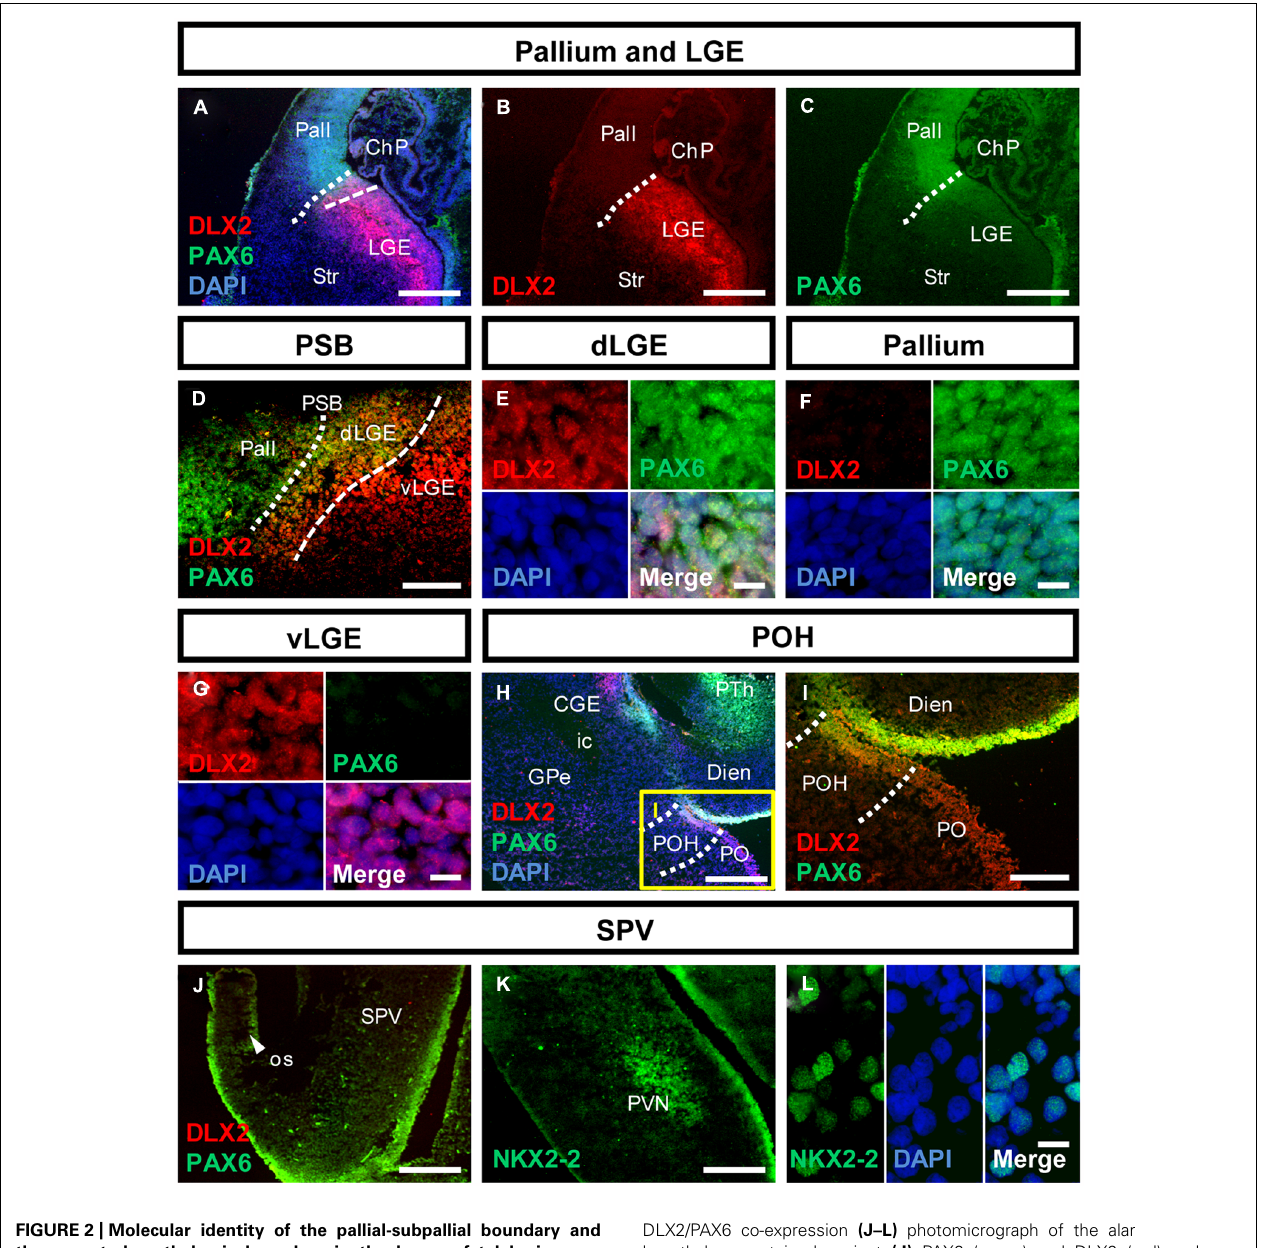
FIGURE 2 | Molecular identity of the pallial-subpallial boundary and the preopto-hypothalamic boundary in the human fetal brain. (A–C) Photomicrographs of coronal human subpallial sections stained against DLX2 (red) and PAX6 (green); (D) the dLGE co-expresses DLX2 and PAX6. (E–G) : co-expressing DLX-2 positive and PAX6-positive cells were detected in the dLGE but not in the Pallium or LGE. (H,I) The boundary between subpallium and hypothalamus is characterized by